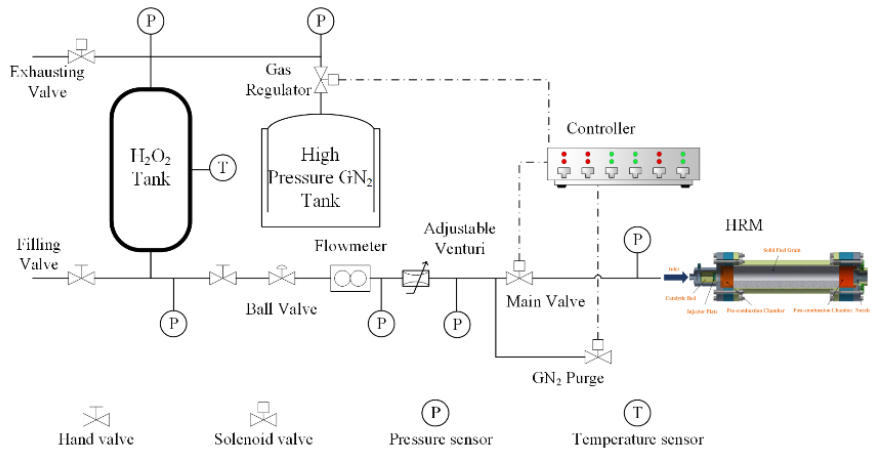
Figure 8. Feed system of hydrogen peroxide.